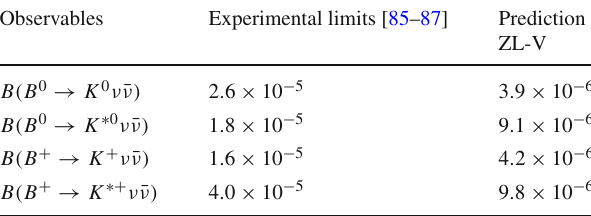
Table 7 Predictions of branching ratios of decays induced by b → s ν ¯ ν transitions in the light Z (cid:4) model with couplings both to muons and neutrinos. The experimental as well as theoretical limits are at 90% CL. The predictions for ZL-VI scenario are the same Observables Experimental limits